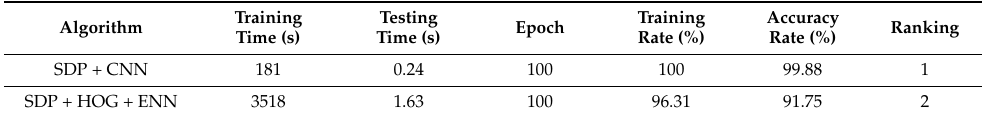
Table 3. Comparison of CNN and ENN recognition results.